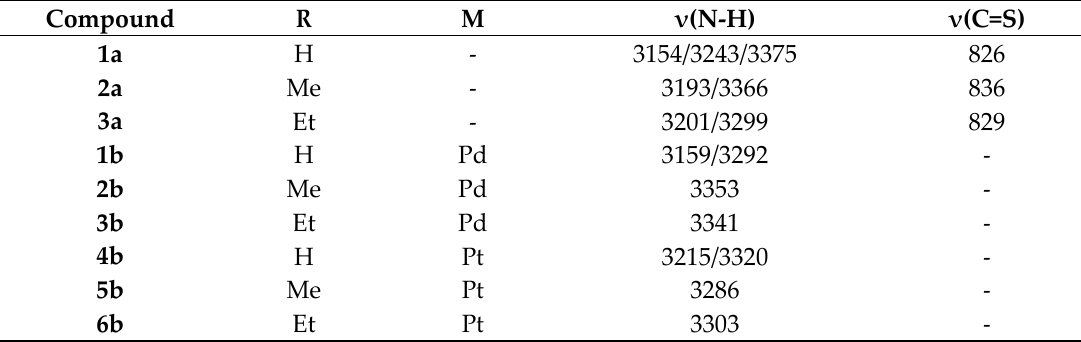
Table 4. IR spectroscopy